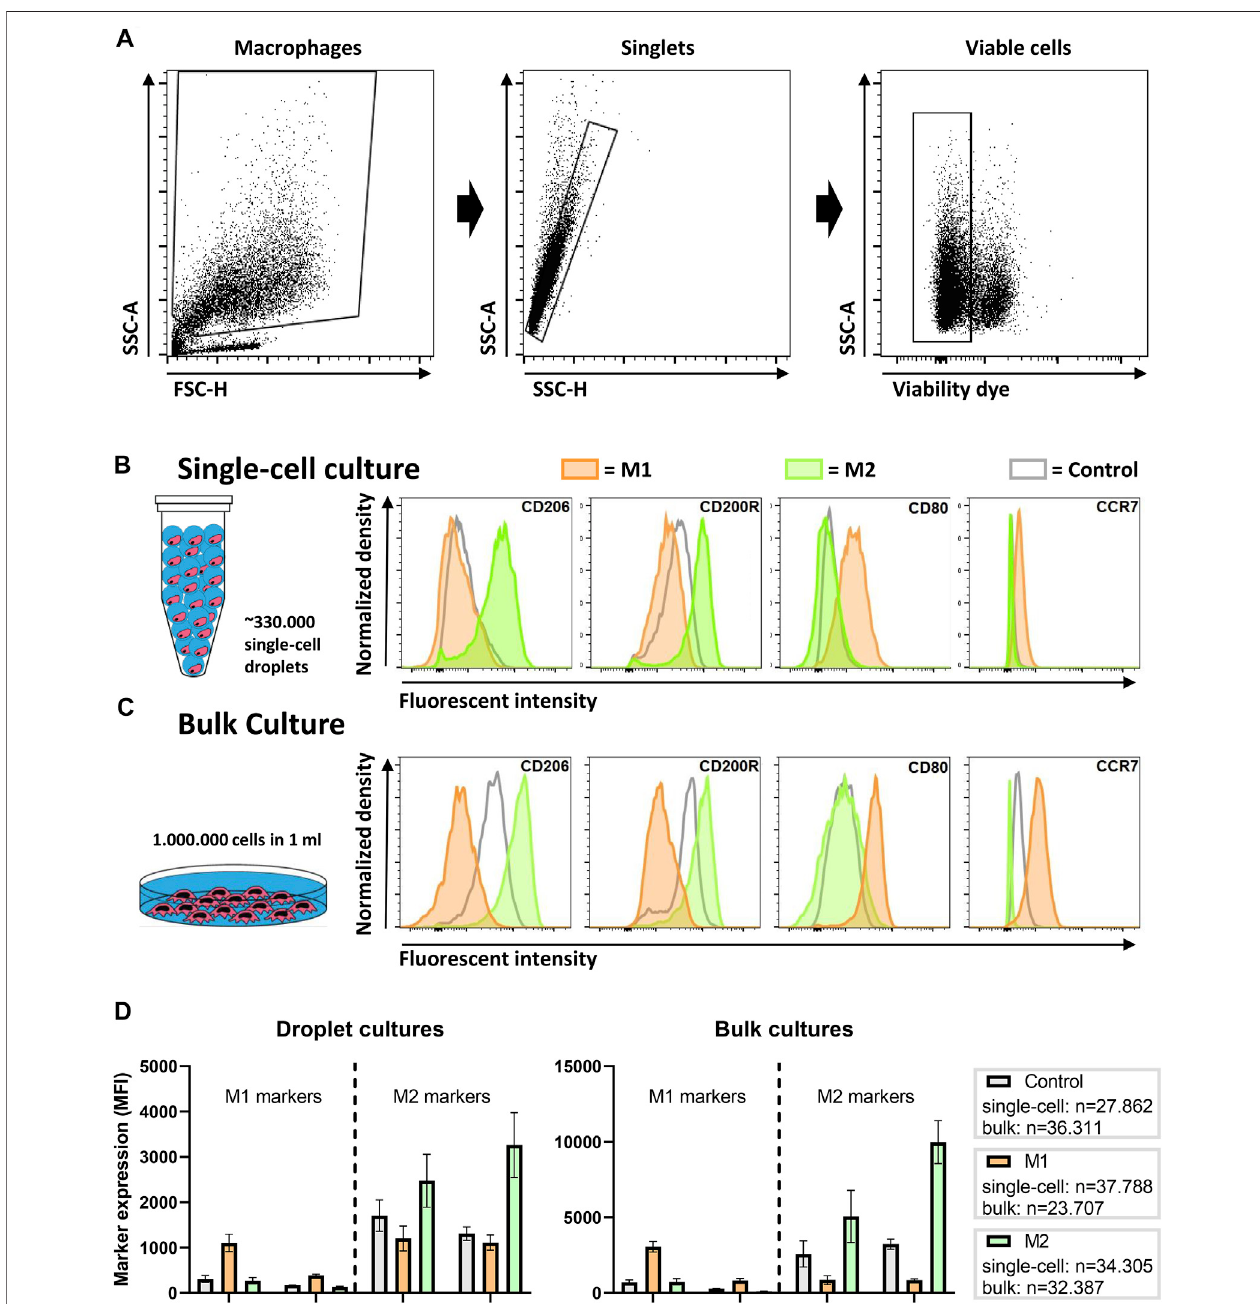
FIGURE 2 | Macrophage polarization in droplets as compared to conventional bulk culture. (A) Gating strategy; cells are gated from debris, single cells are gated fromdoubletsandviablecellsaregatedfromdeadcells. (B) Expressionofsinglemacrophagespolarizedfor2 daysindropletswithLPS+IFN- γ (M1),IL-4+IL-13(M2)or as a control without additional cytokines. Histograms are taken from one representative donor. (C ) Expression of macrophages polarized in bulk culture for 2 days with M1 and M2 cytokines or as a control without additional cytokines. Histograms are taken from one representative donor. (D ) Bar graphs representing marker expression of M1 and M2 stimulated macrophages in bulk and droplet culture compared to control. Data represents four independent donors. “ n ” indicates number of cells measured from all donors combined.